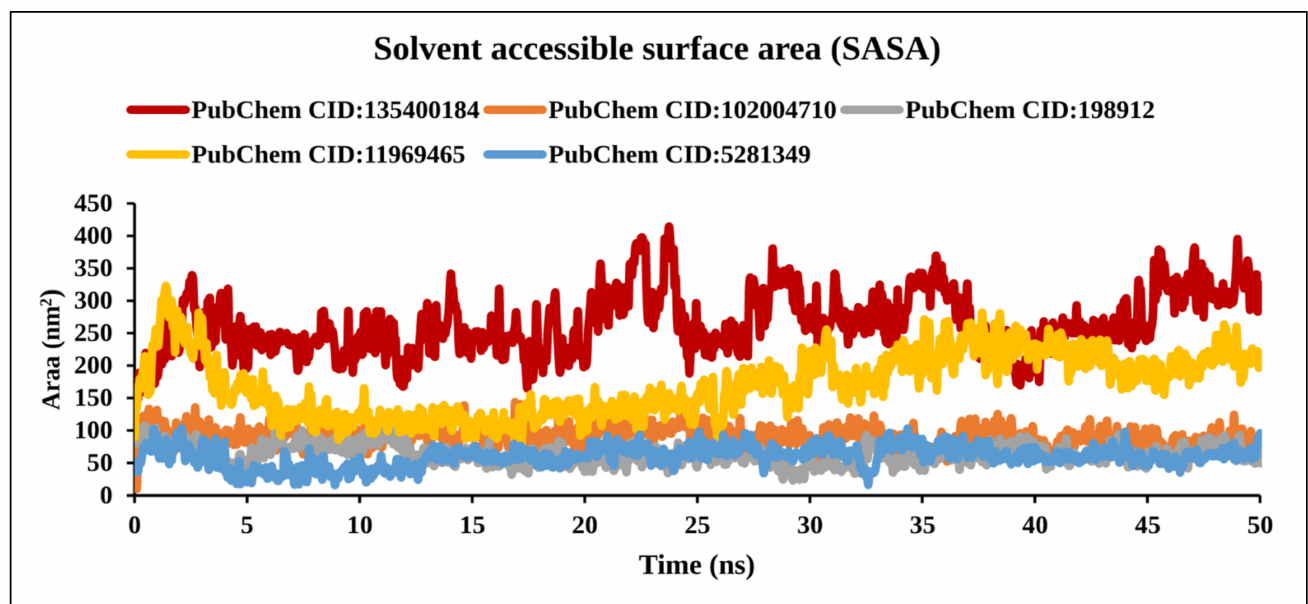
Figure 12. Line graph detailing the solvent-accessible surface area of TS and four compound com- plexes. The solvent accessible surface area (SASA) of the selected compound is represented by the Y-axis and the time frames are represented by the